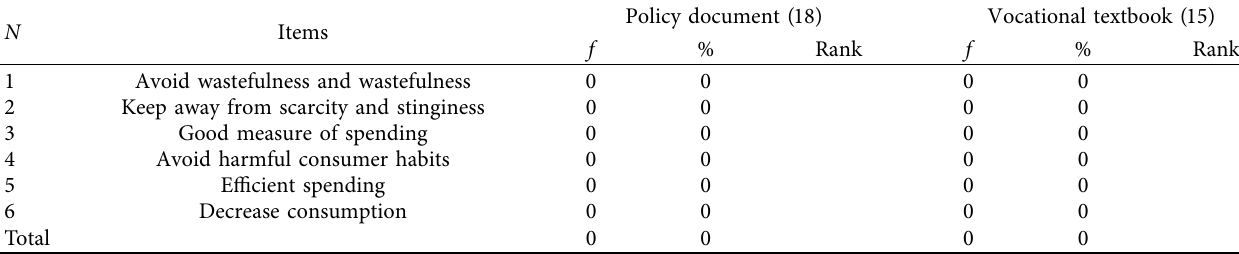
Table 3: The descending order of the economic values related to the moderation in spending contained in the provisions of the Saudi Arabian vocational textbook (15 lessons) and the Educational Policy Document. N